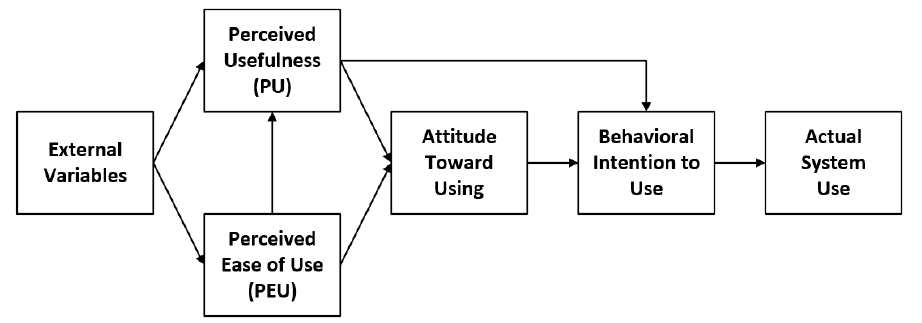
Figure 1. Technology Acceptance Model